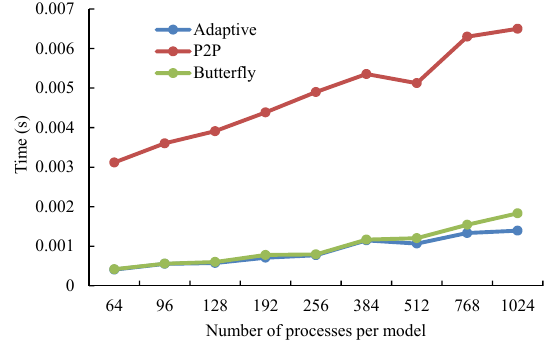
Figure 18. Average execution time ( y axis) of one data transfer be- tween two toy models. In this evaluation, each process (running on a unique processor core) of the toy models has 96 grid points, while different processes have a different number of MPI messages and different message sizes in the P2P implementation. The number of coupling fields transferred is set to 20.